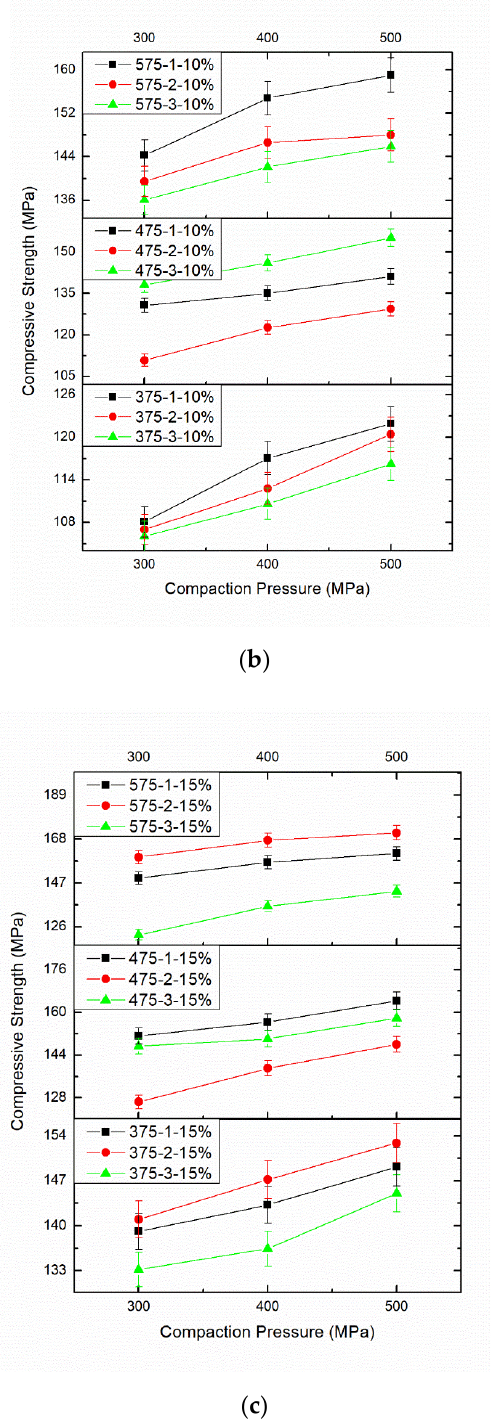
Figure 9. ( a ). Effect of different compaction pressure (300, 400, and 500 MPa), different sintering time (1, 2, and 3 h), sintering temperature (375 °C, 475 °C, and 575 °C), and 5wt%.B 4 C on compressive strength. ( b ). Effect of different compaction pressure (300, 400, and 500 MPa), different sintering time (1, 2, and 3 h), sintering temperature (375 °C, 475 °C, and 575 °C), and 10wt%.B 4 C on compressive strength. ( c ) . Effect of different compaction pressure (300, 400, and 500 MPa), different sintering time (1, 2, and 3 h), sintering temperature (375 °C, 475 °C, and 575 °C), and 15wt%.B 4 C on compressive strength.